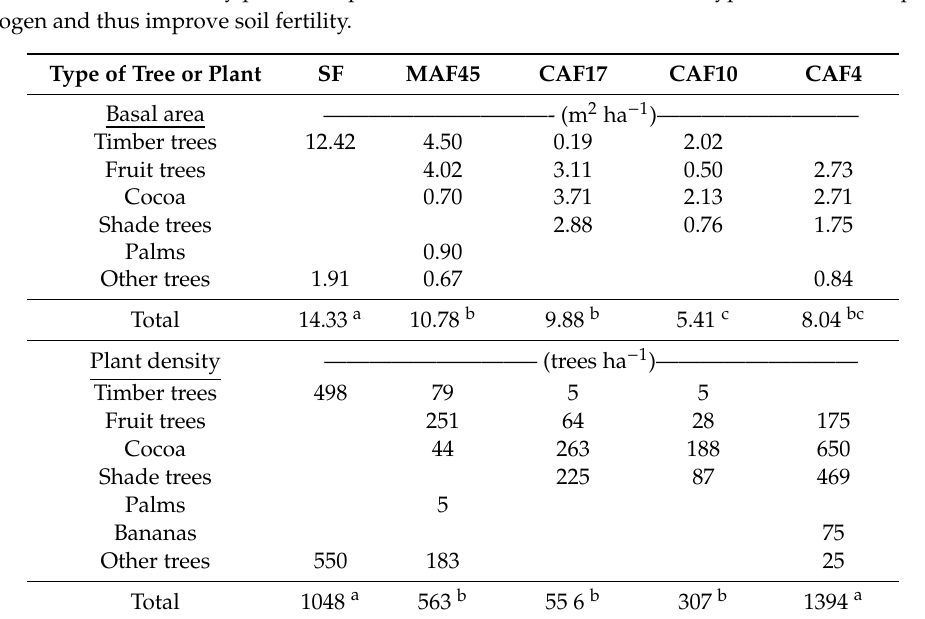
Timber trees Fruit trees